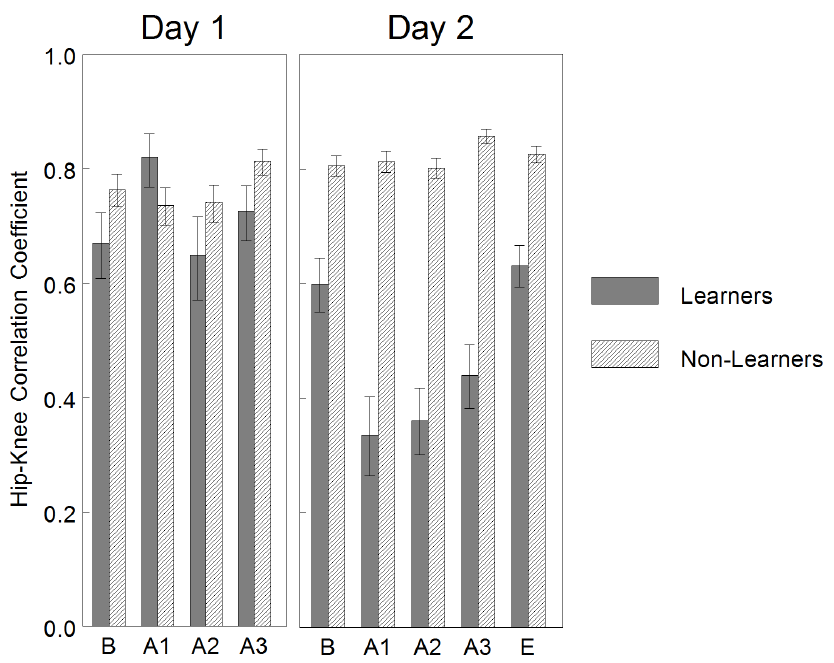
Figure 8. Learners versus non-learners: mean correlation coefficients of hip-knee pair by interval. On Day 1, there were no significant differences in hip-knee correlation coefficients. On Day 2, between-group hip-knee correlation coefficients during each interval were significantly decreased in the Learner group as compared to the Non-Learner group (less in-phase hip-knee joint coordination). Within-group, the Learner group demonstrated a significant decrease in hip-knee correlation coefficients in the first and second acquisition interval as compared to baseline (performance criteria). Within-group, the Non-Learner group did not demonstrate a significant change between baseline and any acquisition interval (performance criteria). This can be interpreted as the Learner group demonstrated less in-phase hip-knee coordination when interacting with the mobile on Day 2, but not Day 1. The Non-Learner group did not demonstrate a change in hip-knee coordination either day. Error bars are standard errors. B=baseline, A=acquisition,